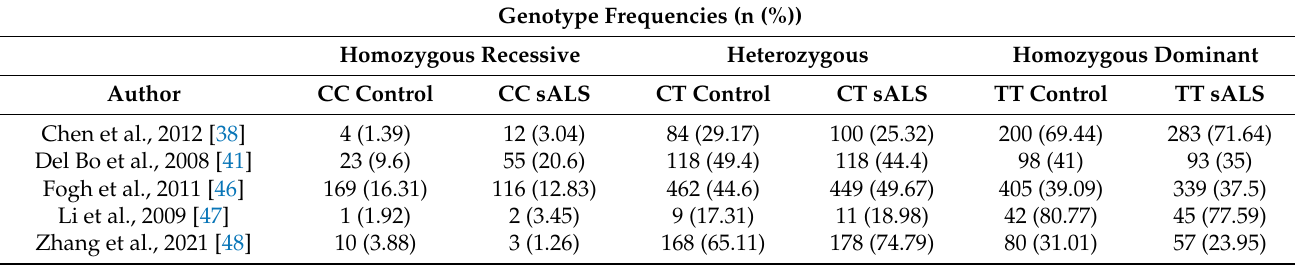
Table 2. Characteristics of the studies included in the meta-analyses. Genotype frequencies in variant SNP rs10260404 within DPP6 gene between SALS group and control